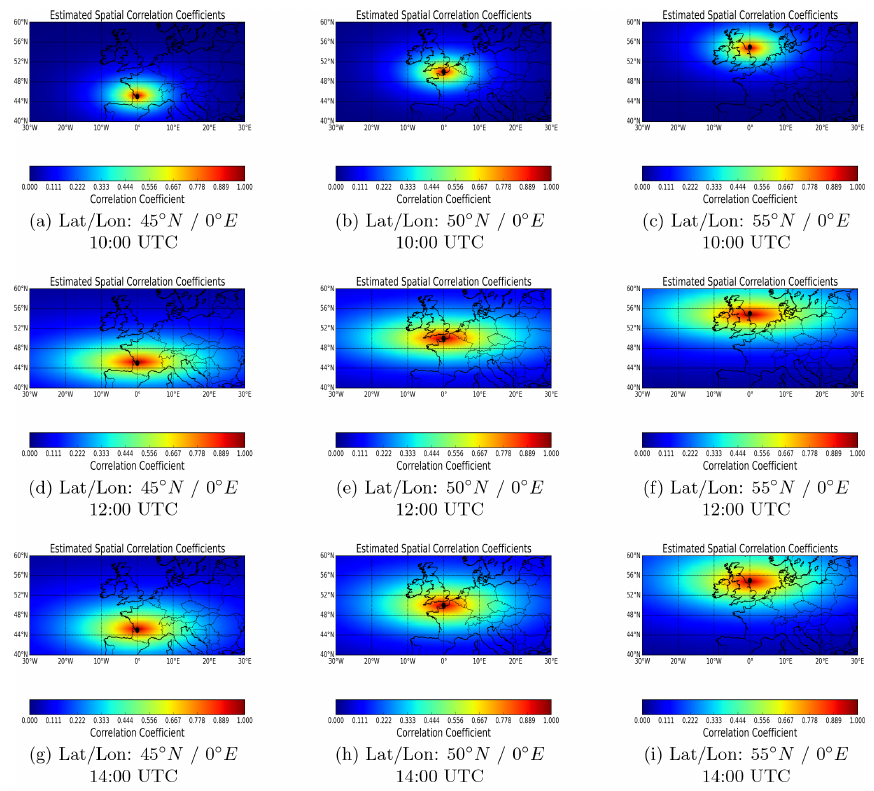
Figure 2. Correlation coefficients between selected coordinates (black dots) and their adjacent coordinates at a height of 300km for DOY 22 (2011) at 10:00, 12:00 and 14:00UTC.